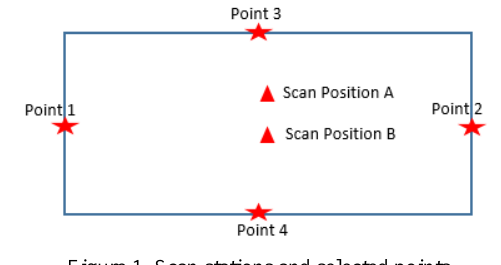
Figure 1. Scan stations and selected points